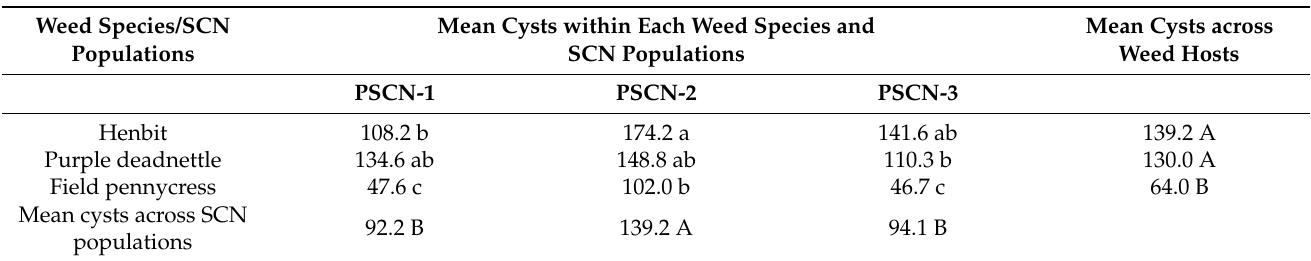
Table 3. Effect of weed species and soybean cyst nematode (SCN) populations on cysts development under greenhouse